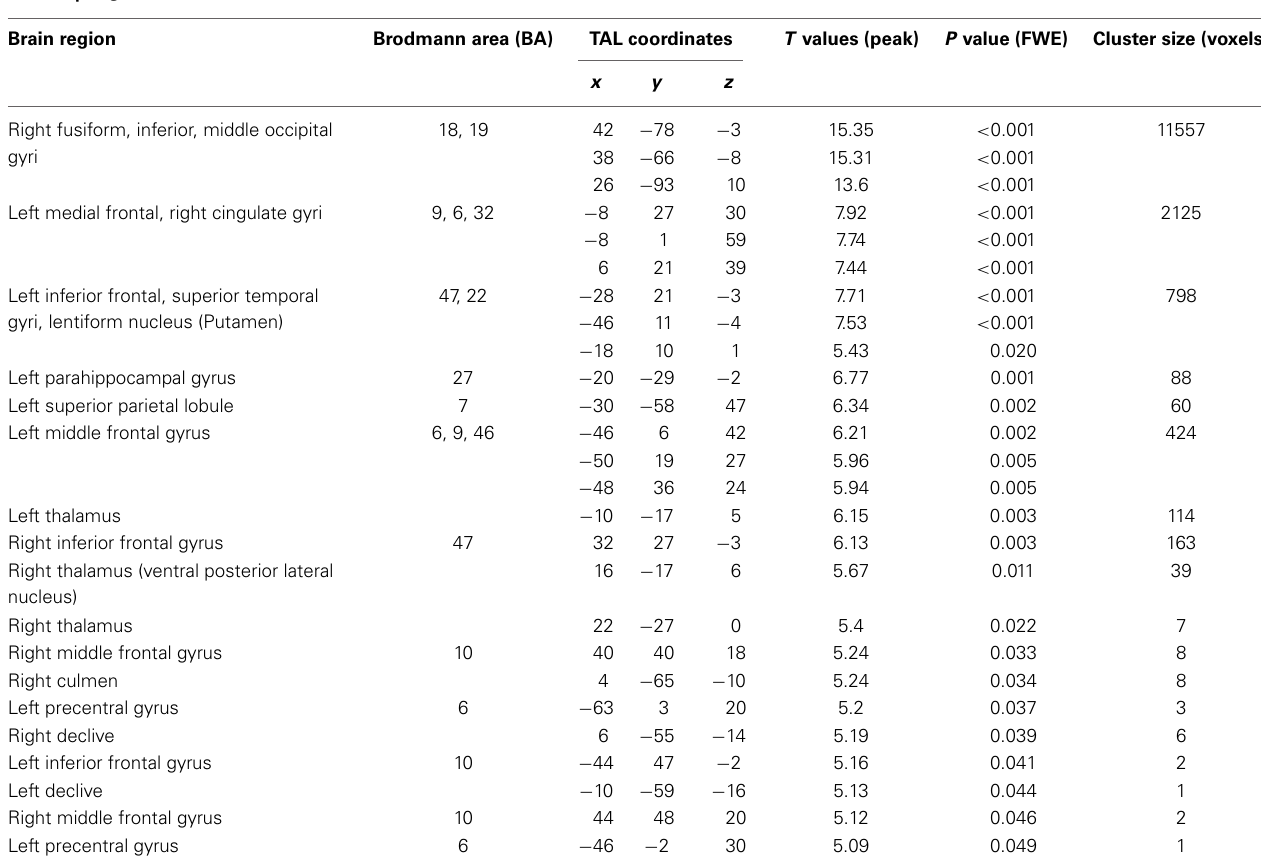
FIGURE 2 | Brain activation during the phonological processing fMRI task. Clusters in warm colors indicate those significant at p < 0 . 05 family wise error (FWE) corrected. Those significant at p < 0 . 001 Table 2 | Regional brain